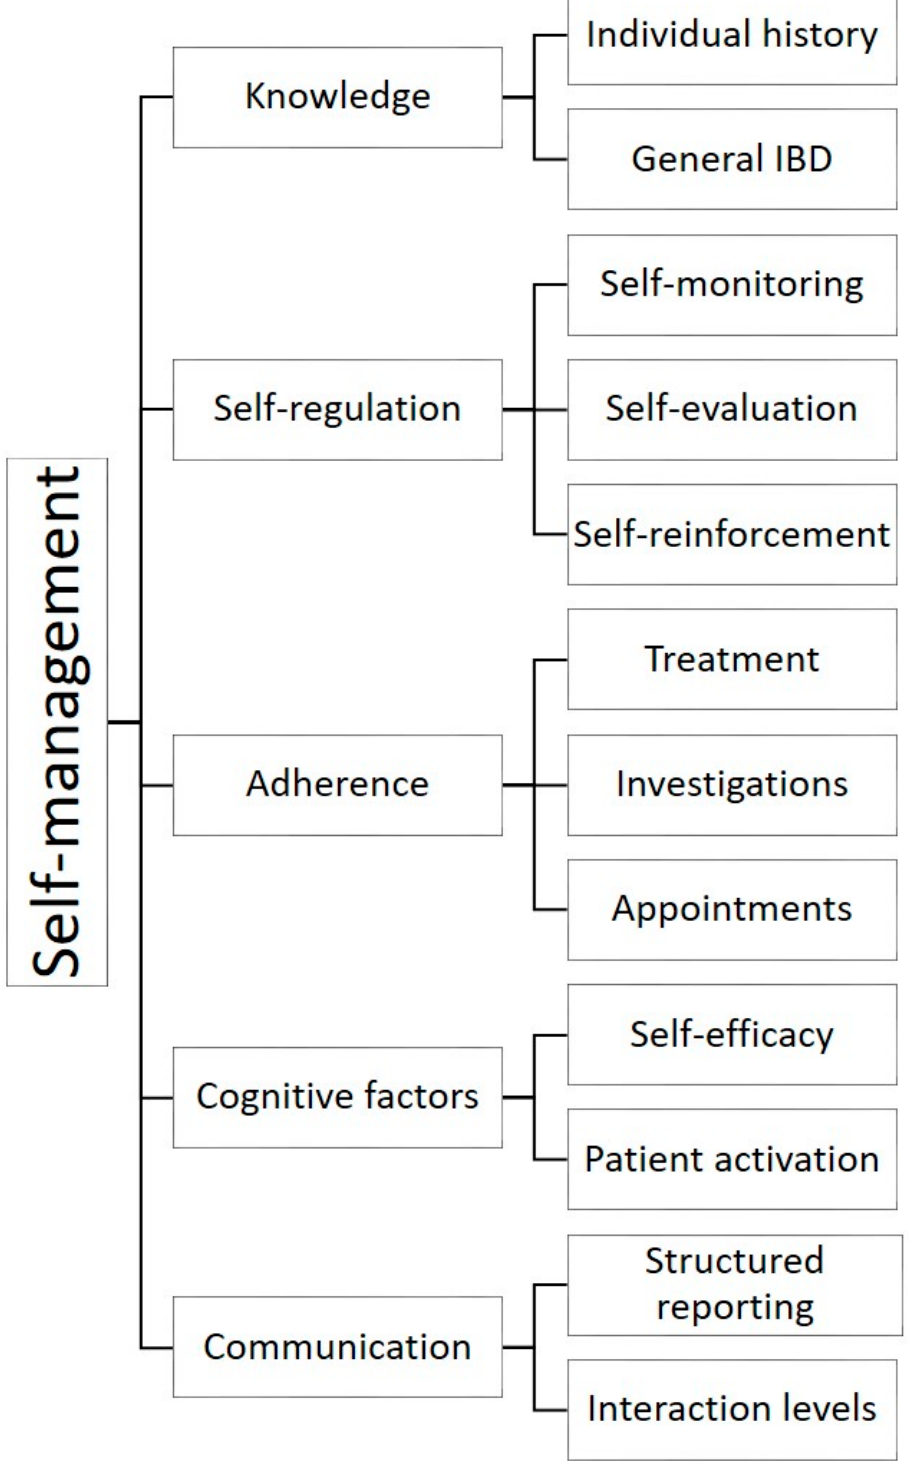
Figure 1. Factors relating to the development of self-management skills.